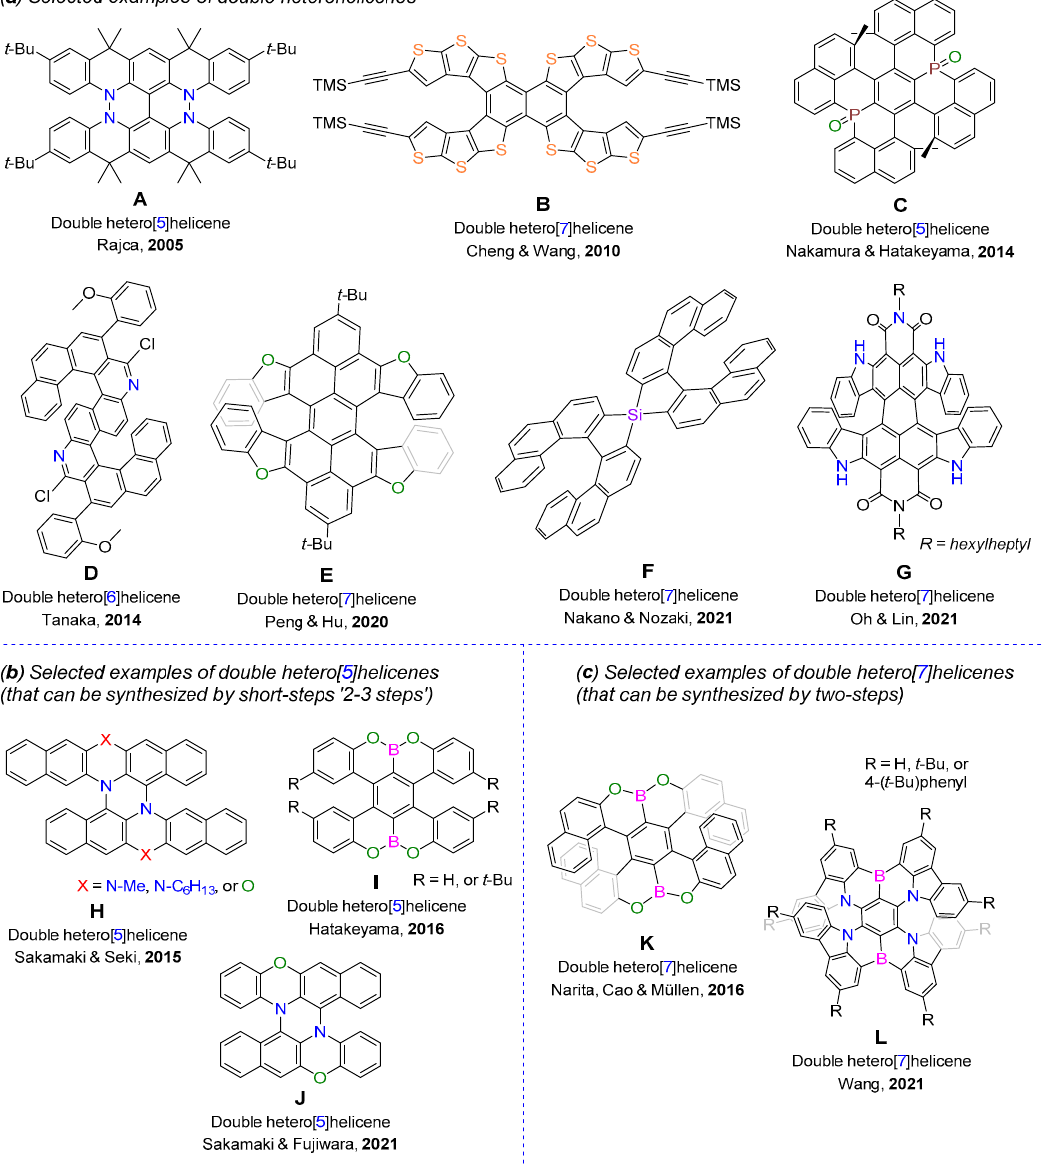
Figure 1. The selected examples of double heterohelicenes in short ‐ step synthesis: ( a ) Double hetero[5–7]helicenes (more than four ‐ step synthesis) ; ( b ) Double hetero[5]helicenes (two ‐ or three ‐ step synthesis); ( c ) Double hetero[7]helicenes (two ‐ step synthesis).